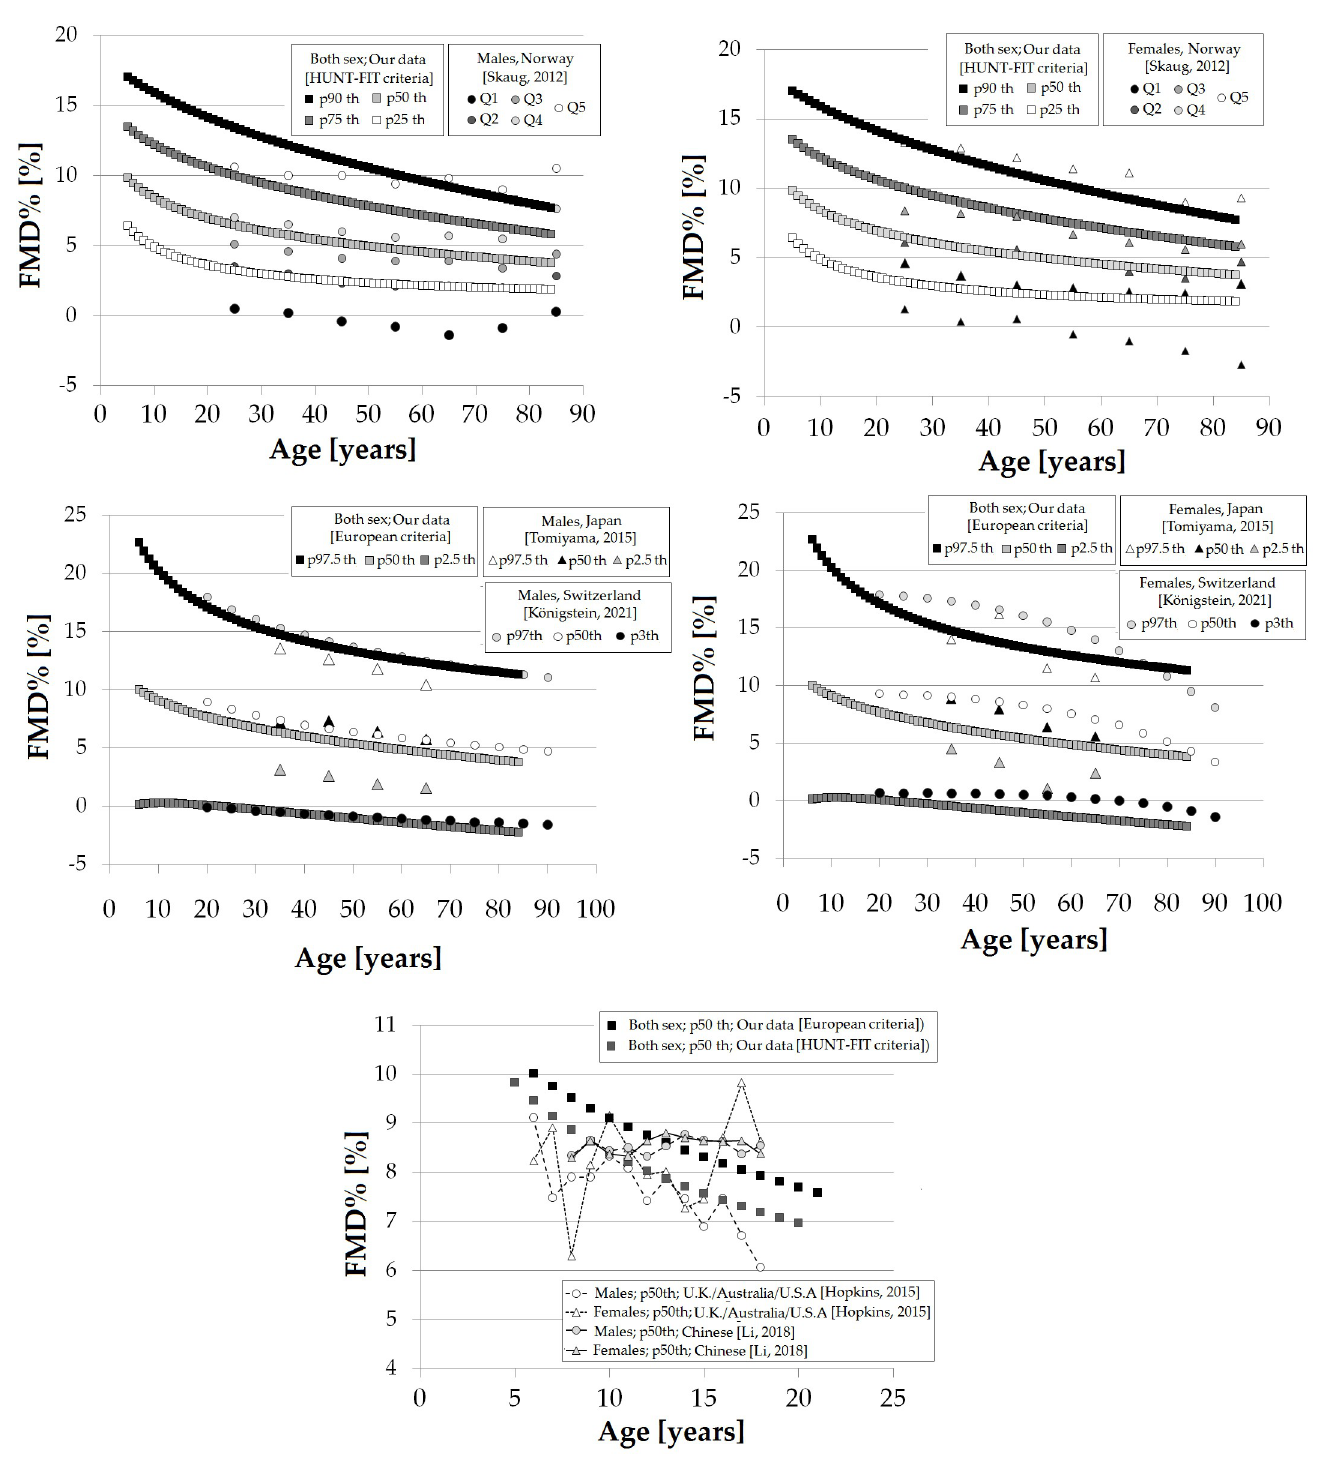
Fig 11. Comparative age-related FMD% profiles for adults (top, middle) and for children and adolescents (bottom). U.K.: United Kingdom. U.S.A.: United States of America.